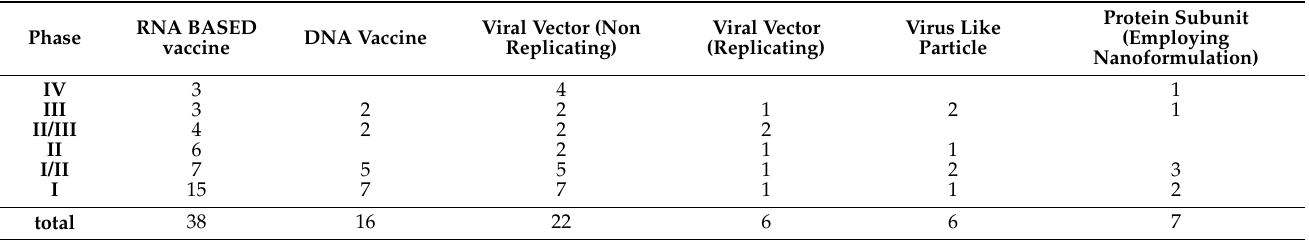
Table 4. SARS-CoV-2 and other virus vaccines employing nanoformulation in clinical trials (updated to 1 July 2022)